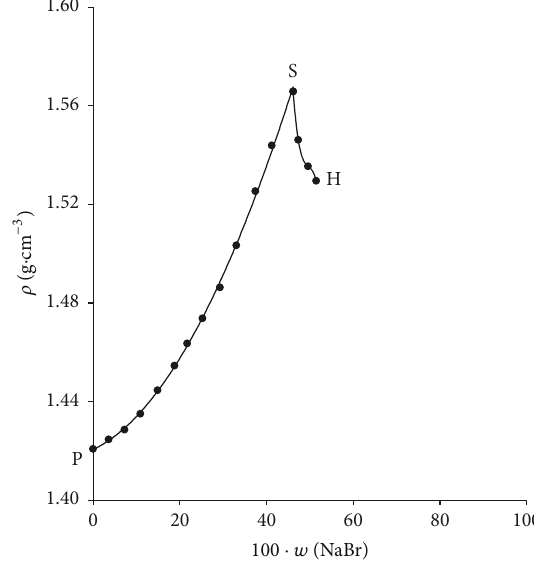
Figure 2: Density versus 100𝑤 (NaBr) in the ternary system (NaBr + KBr + H 2 O). H, S, and P have the same meaning as described in Figure 1. of KBr and NaBr ⋅ 2H 2 O at 313.15 K, with 𝑤 (NaBr) = 0.4612 and 𝑤 (KBr) = 0.0820; P and H denote the solubility of KBr and NaBr in water at 313.15 K, respectively. Two univariant solubility curves of this ternary system are PS and HS. Curve PS corresponds to the saturated KBr solution and visualizes changes of the KBr concentration with increasing the